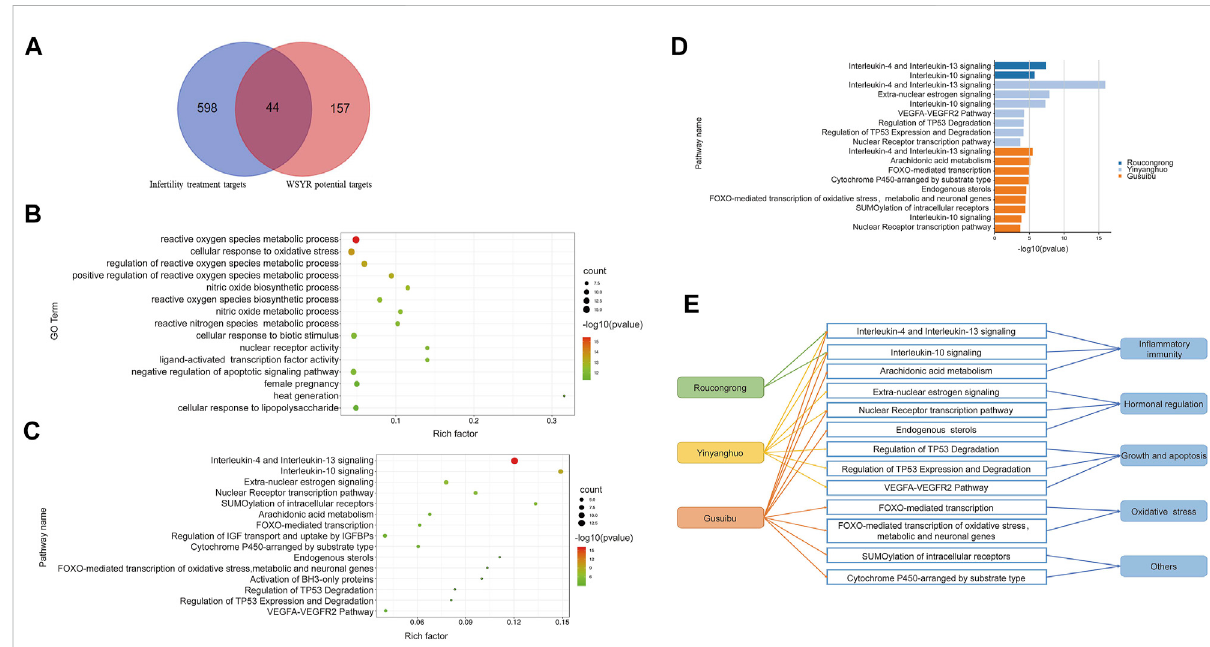
FIGURE 2 Functional analysis of infertility-related targets of WSYR identi fi ed in dry experiments (A) Venn diagram of the potential targets in WSYR and the therapeutic targets for infertility (B) Bubble chart of GO biological process enrichment analysis of 44 infertility treatment targets in WSYR (C) Bubble chart of pathway enrichment analysis of 44 infertility treatment targets in WSYR ( p value ≤ 10 − 3 ) (D) Pathway enrichment analysis of infertility treatment-related targets of Roucongrong, Yinyanghuo and Gusuibu ( p value ≤ 10 − 3 ) (E) Comparison of pathways regulated by Roucongrong, Yinyanghuo and